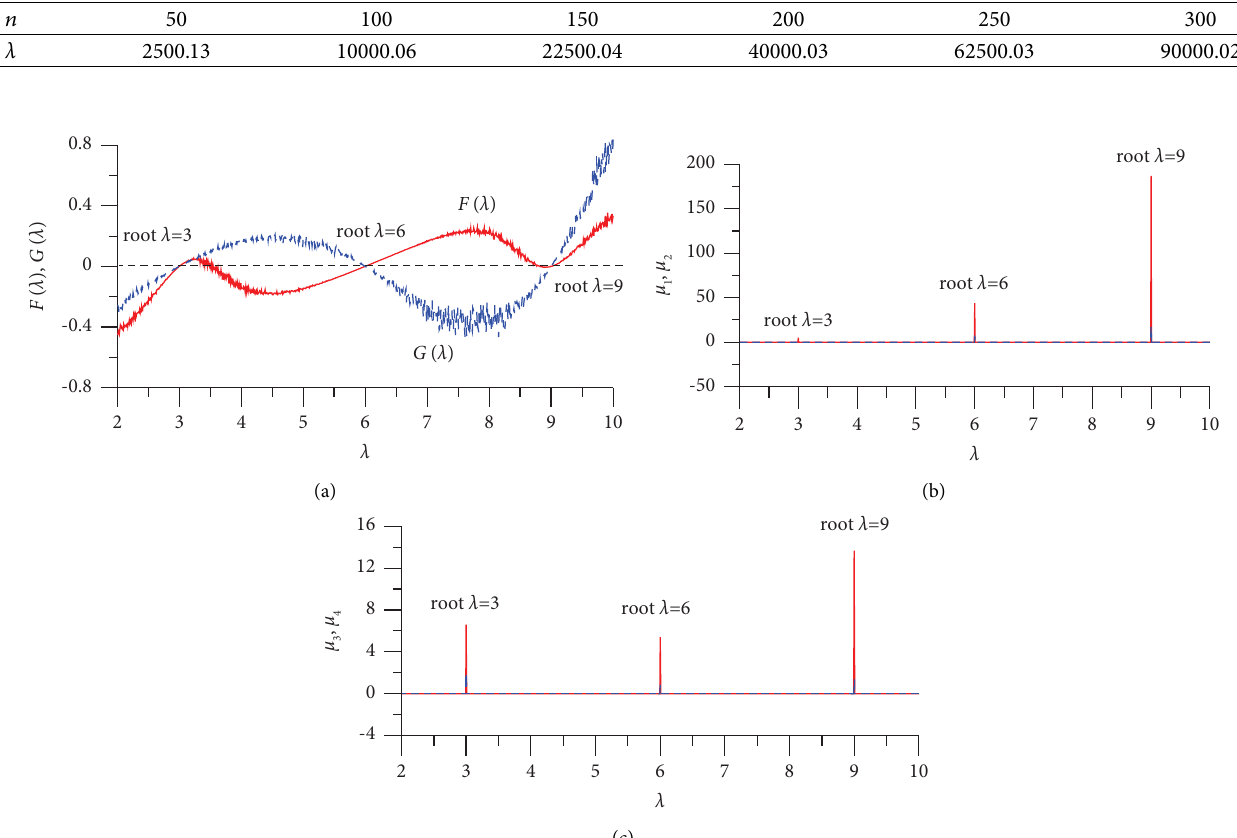
� 5, the asymptotic eigenvalues for diferent n . 0